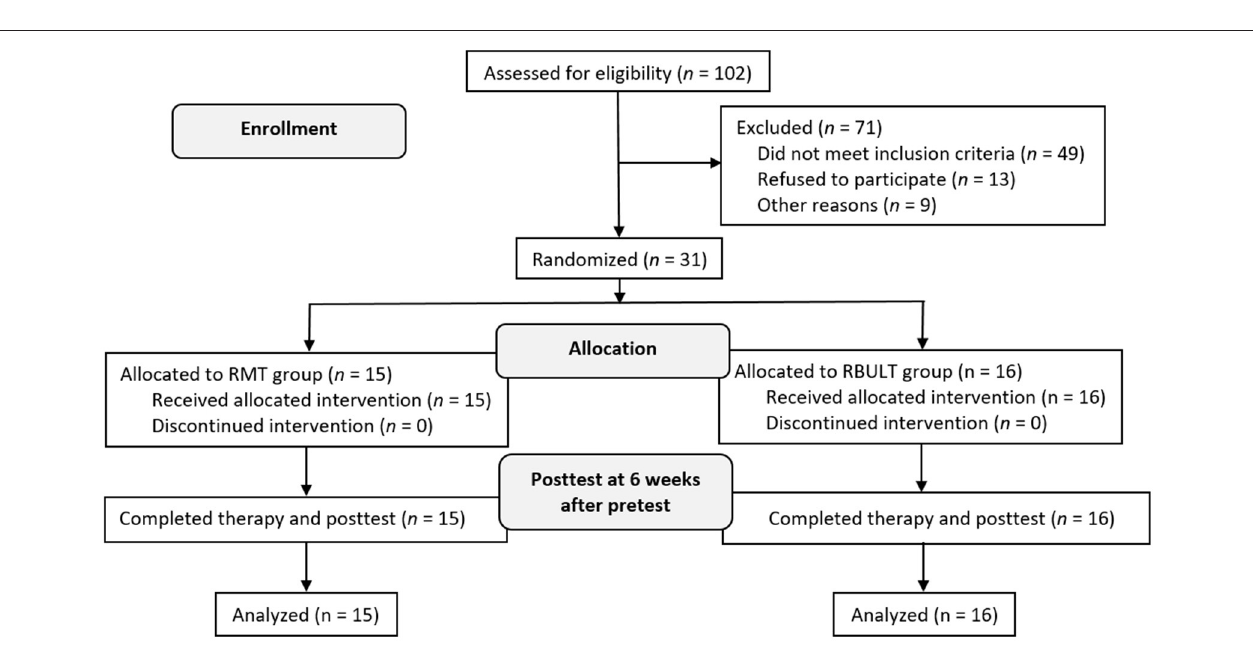
FIGURE 2 | Consolidated standards of reporting trials flowchart of the